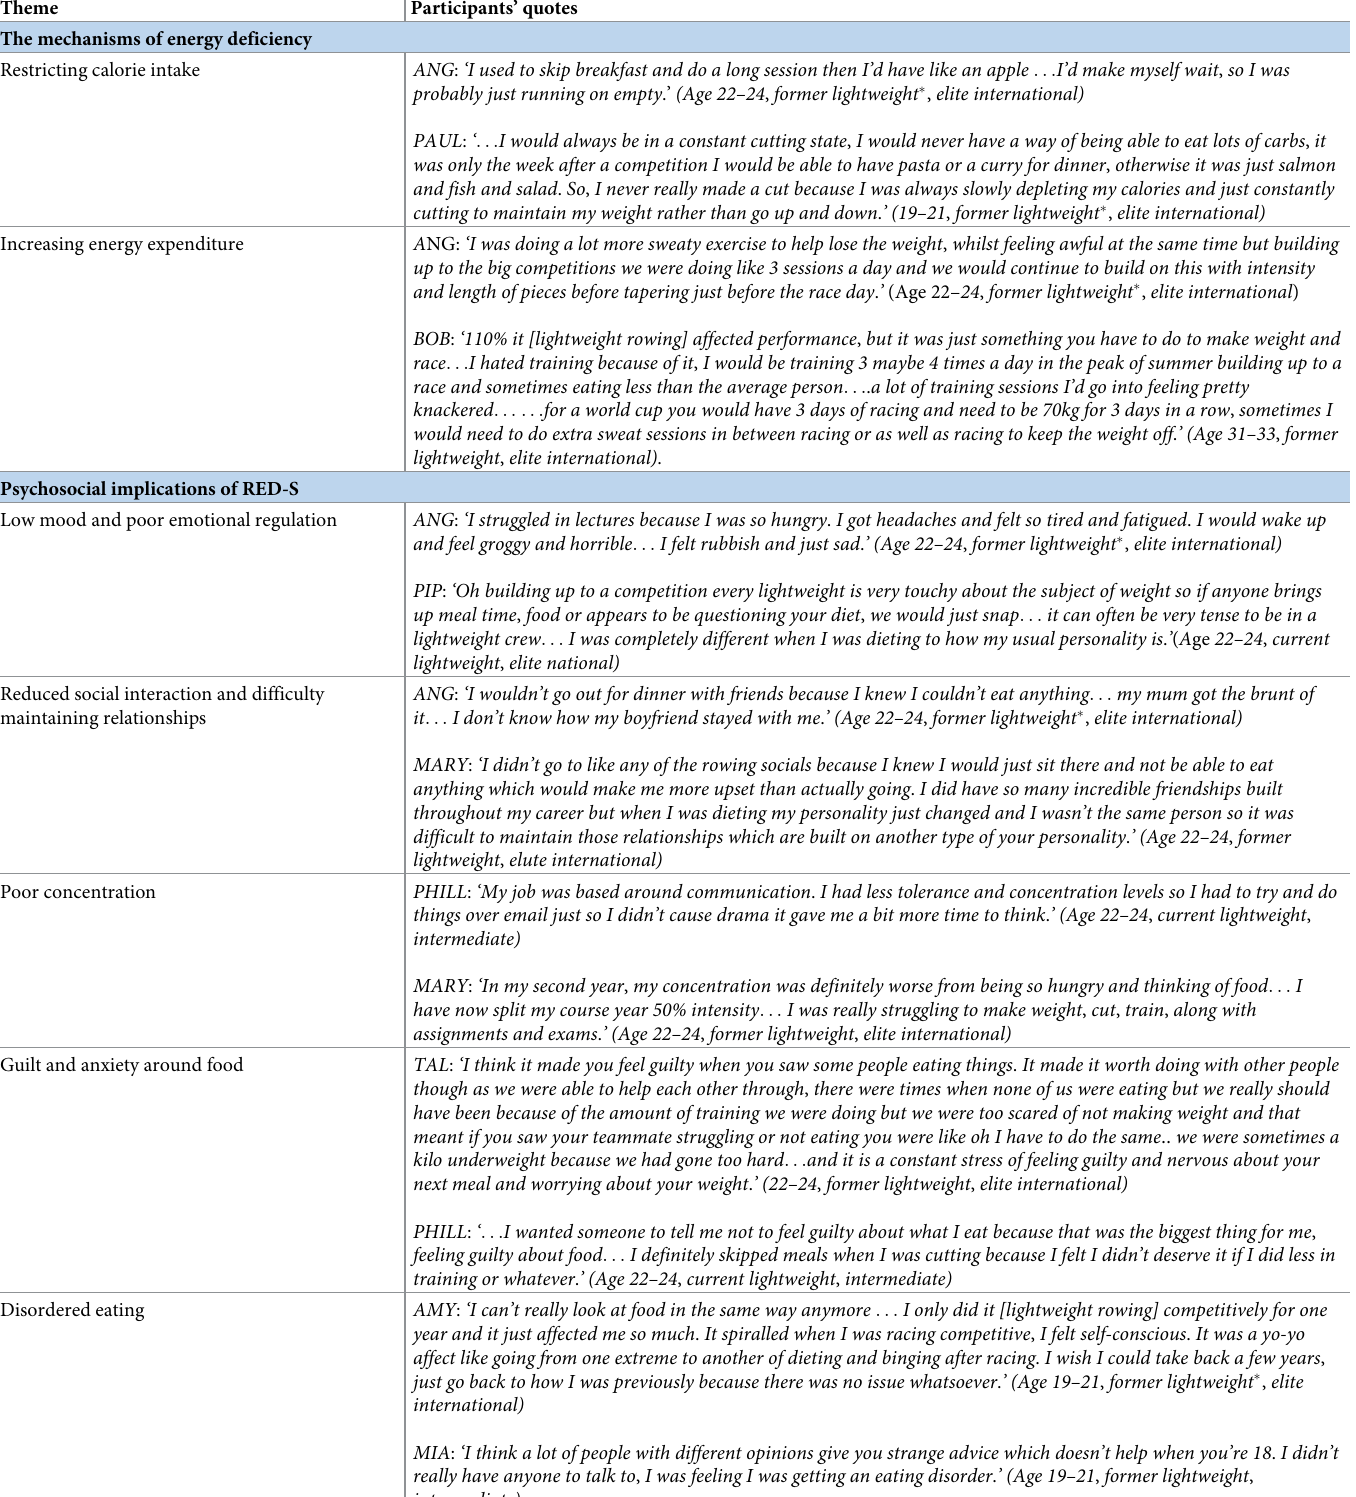
Table 2. Additional quotations illustrating the key